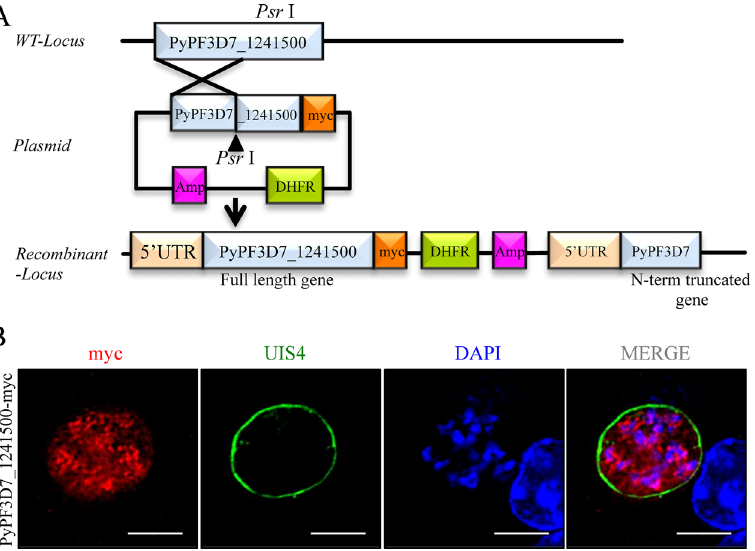
Fig 4. Expression of novel antigens by Py LS parasites. (A) Strategy for generation of myc-tagged Py PF3D7_1241500. (B) Immunofluorescence assay using Py 17XNL grown 24h in HepG2-CD81 cells, showing expression of Py PF3D7_1241500 protein detected by Alexa-594 conjugated anti-myc antibody (red). UIS4 (green) was used as a PVM marker and DAPI to identify nuclei. Scale bar represents 10 μ